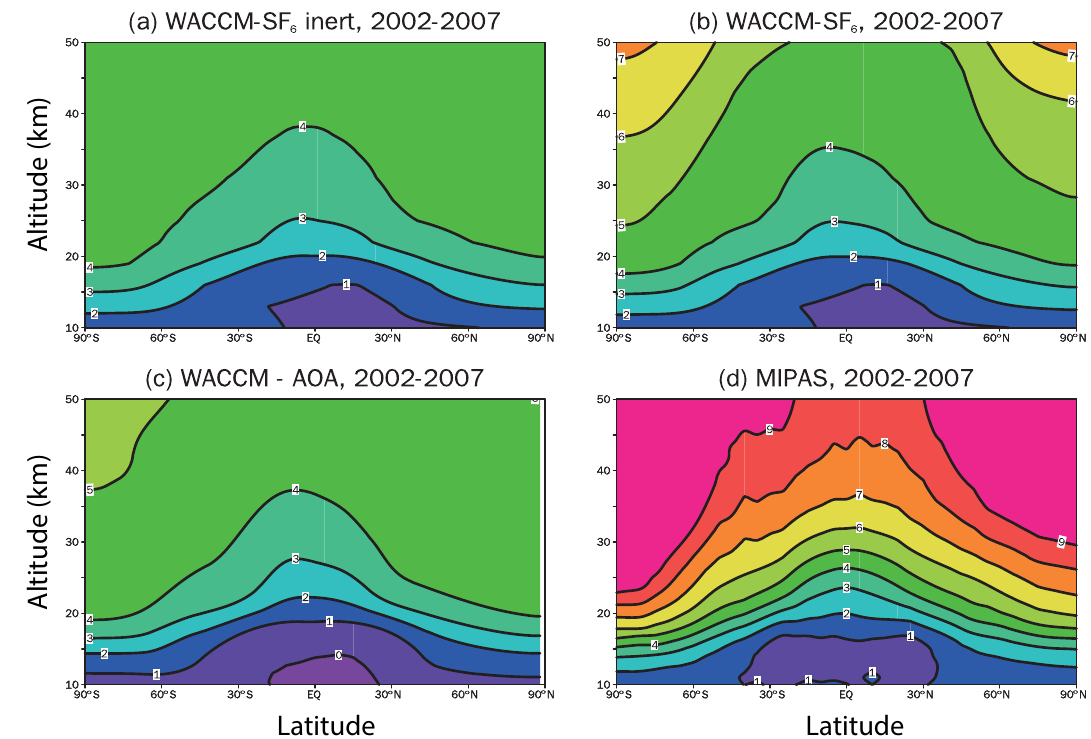
Figure 7. Annual mean age of stratospheric air (years) for the period of 2002–2007 determined from a WACCM simulation using (a) the inert SF 6 tracer; (b) the total reactive SF 6 tracer; (c) the idealized AOA1 tracer. Panel (d) shows the age values derived for the same period from our analysis of MIPAS SF 6 observations.